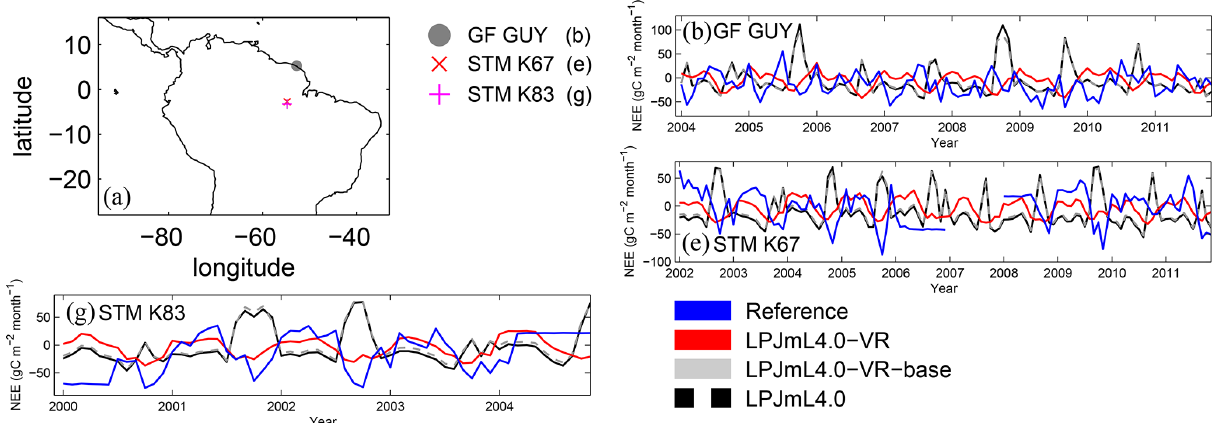
Figure B7. Comparisons of monthly NEE between different FLUXNET sites (Reference; see also Sect. 2.5.1) and respective simulation output of the different LPJmL model versions used in this study forced with CRU climate. (a) Geographical location of different FLUXNET sites (see also Table A3). For statistical measures of the individual comparison, see Table B2. Note that due to data scarcity only three FLUXNET sites are shown. Plots of all sites are shown in Fig. B12. We kept panel labelling as in Fig. B6 to ensure easy